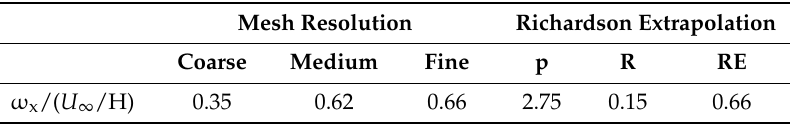
Table 3. Results of the mesh independency study 1 .